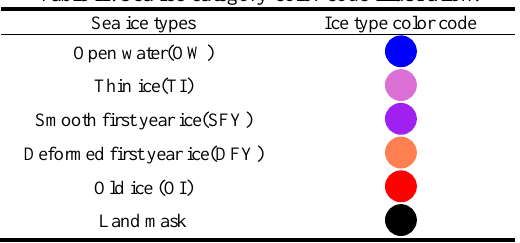
Table II. Sea ice category color code illustration.